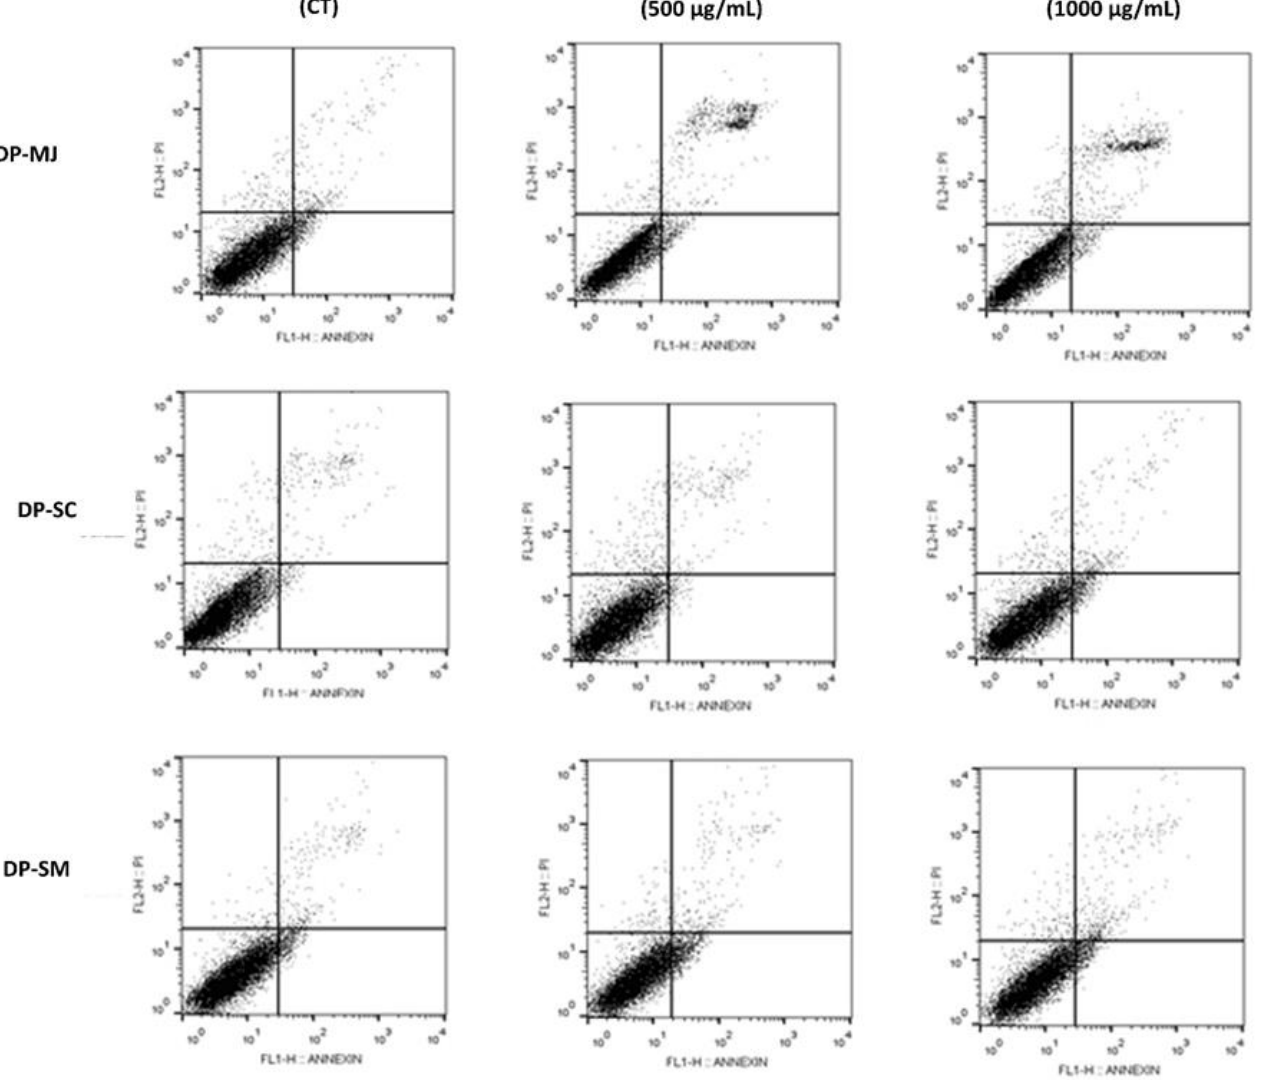
Figure 4. Effect of dried peel powders (DP) extracts of M. jaboticaba (MJ), S. cumini (SC), and S. malaccense (SM) on the process of programmed death in HT-29 cells after treatment for 24 h. Flow cytometry analysis according to the exposure time and extracts concentration (500 and 1000 µg/mL).